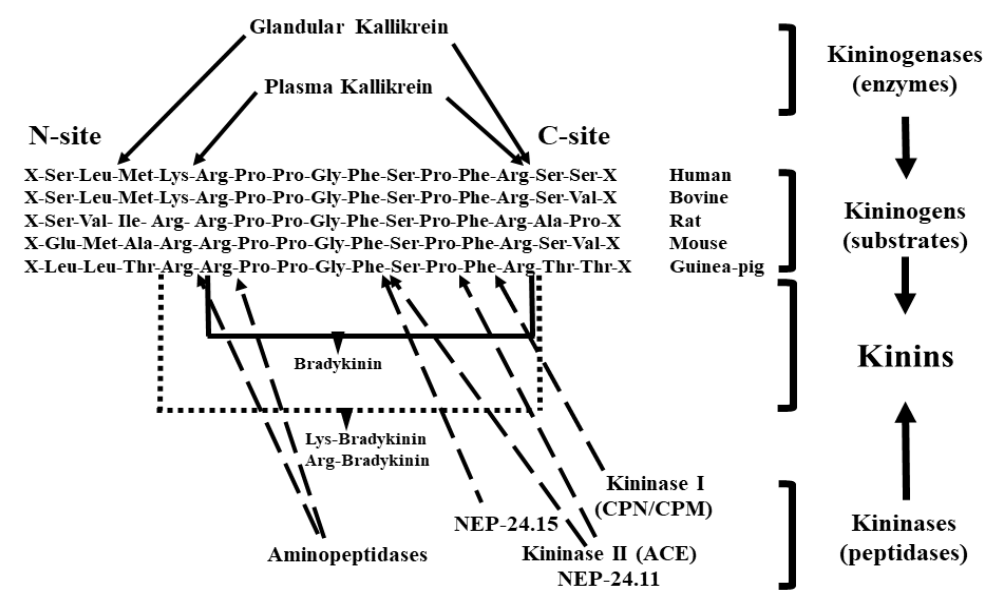
Figure 1. Site of kininogen cleavage (solid arrows) by the main kininogenases (glandular and plasma kallikrein). The broken arrows indicate sites of kinin cleavage by kininases (kininase I, kininase II, neutral endopeptidases 24.11 and 24.15 and aminopeptidases). (Modified after Rhaleb et al. [2,3])